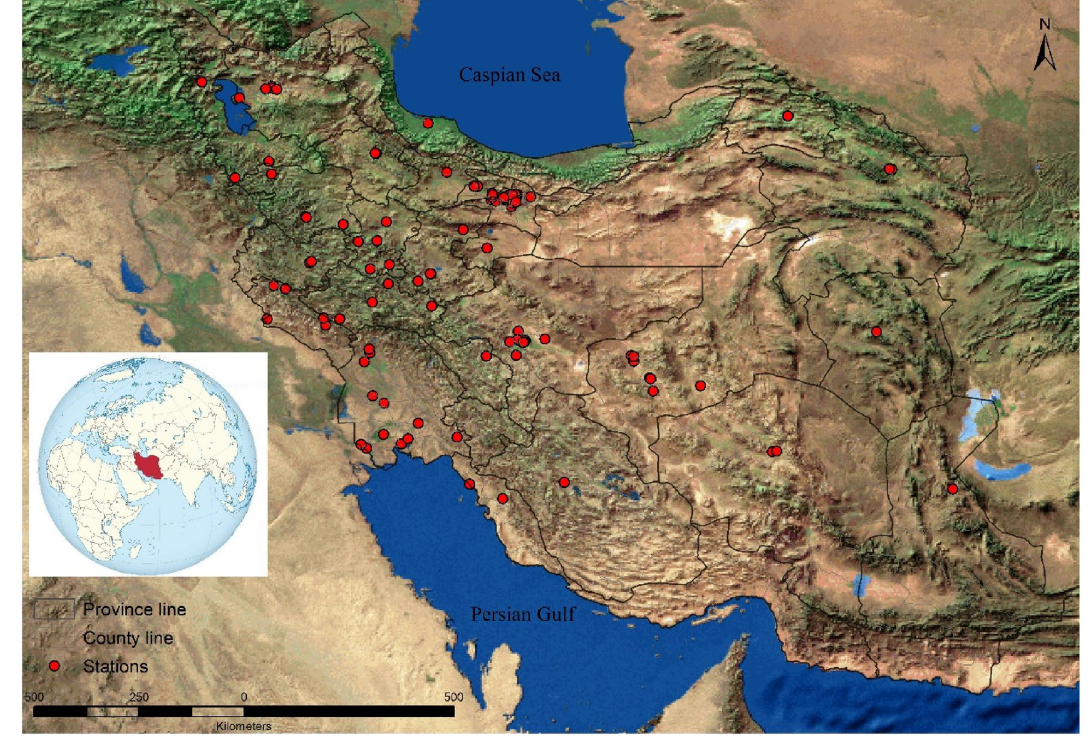
Figure 1. Spatial distribution of AQMSs across Iranian provinces in 2018 (this figure was generated by ArcGIS